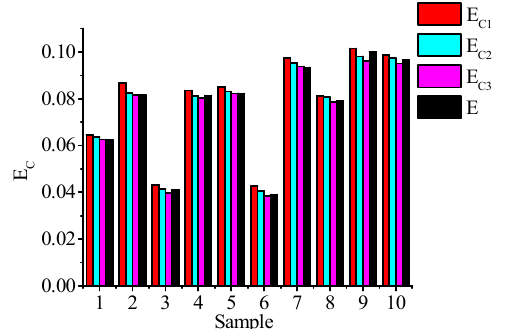
Figure 13. Comparison of calculation results and roundness instrument test results.